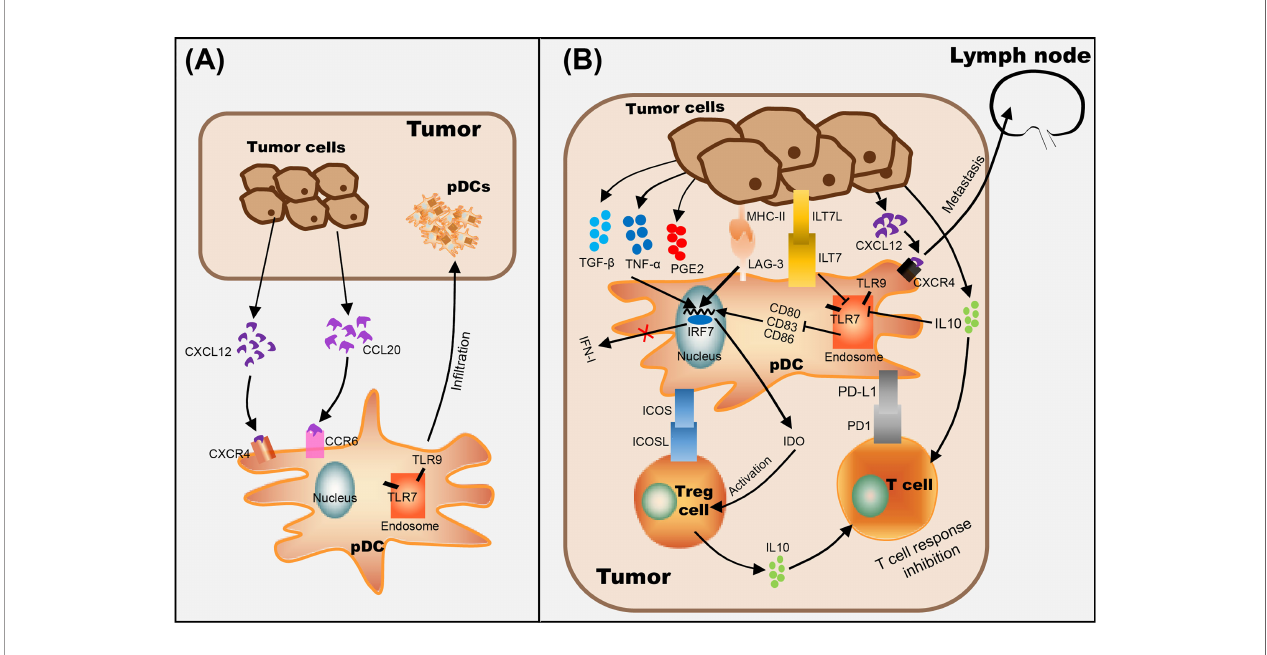
FIGURE 1 | The role of pDCs in tumor progression. (A) pDC recognizes CCL20 secreted by tumor cells through CCR6 on the cell membrane and makes it migrate to the tumor site. (B) Mechanisms of tumor-in fi ltrated pDC on immunosuppression include recruitment of immature pDCs lacking the expression of costimulatory molecules (through CCR6/CCL20 pathway), suppression of type I IFN secretion by pDCs (by ILT7L-ILT7 interaction or immunosuppressive cytokines secreted by tumor cells, such as IL-10), alternate pDC activation (through the interaction between LAG-3 + pDC and MHC II + tumor cells), and/or promote pDC tolerance by activating Tregs (through ICOSL/ICOS interaction and IDO production) and enhancing the expression level of anti-in fl ammatory cytokine IL-10. In addition, the up- regulation of CXCR4 on the surface of pDC and the promotion of CXCL12 secretion by tumor cells are positively correlated with lymph node metastasis of tumor cells.